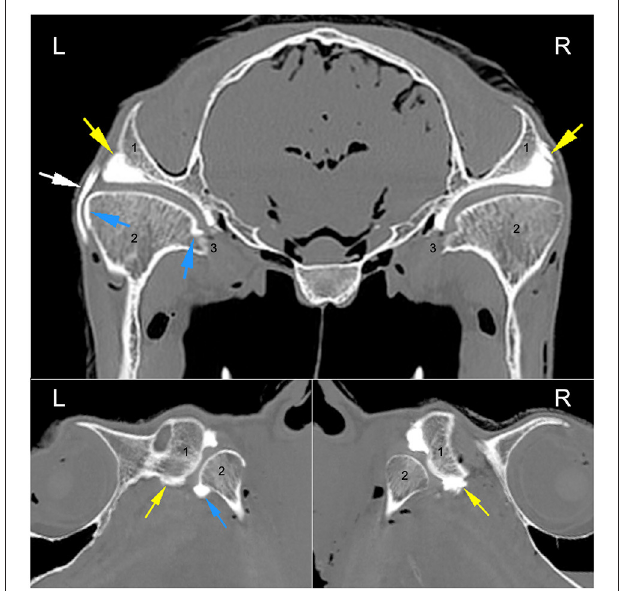
FIGURE 2 | Axial and sagittal CT arthrographic images at the level of the TMJ of the 26-year-old Arabian gelding. Arrows indicate the presence of the radiopaque contrast material in the discotemporal joint (yellow), discomandibular joint (blue), and varying amounts in the subcutaneous tissues (white). L, left; R, right. 1, zygomatic process of the temporal bone; 2, mandibular condyle; 3, medial aspect of the mandibular condyle at the insertion of the pterygoid musculature